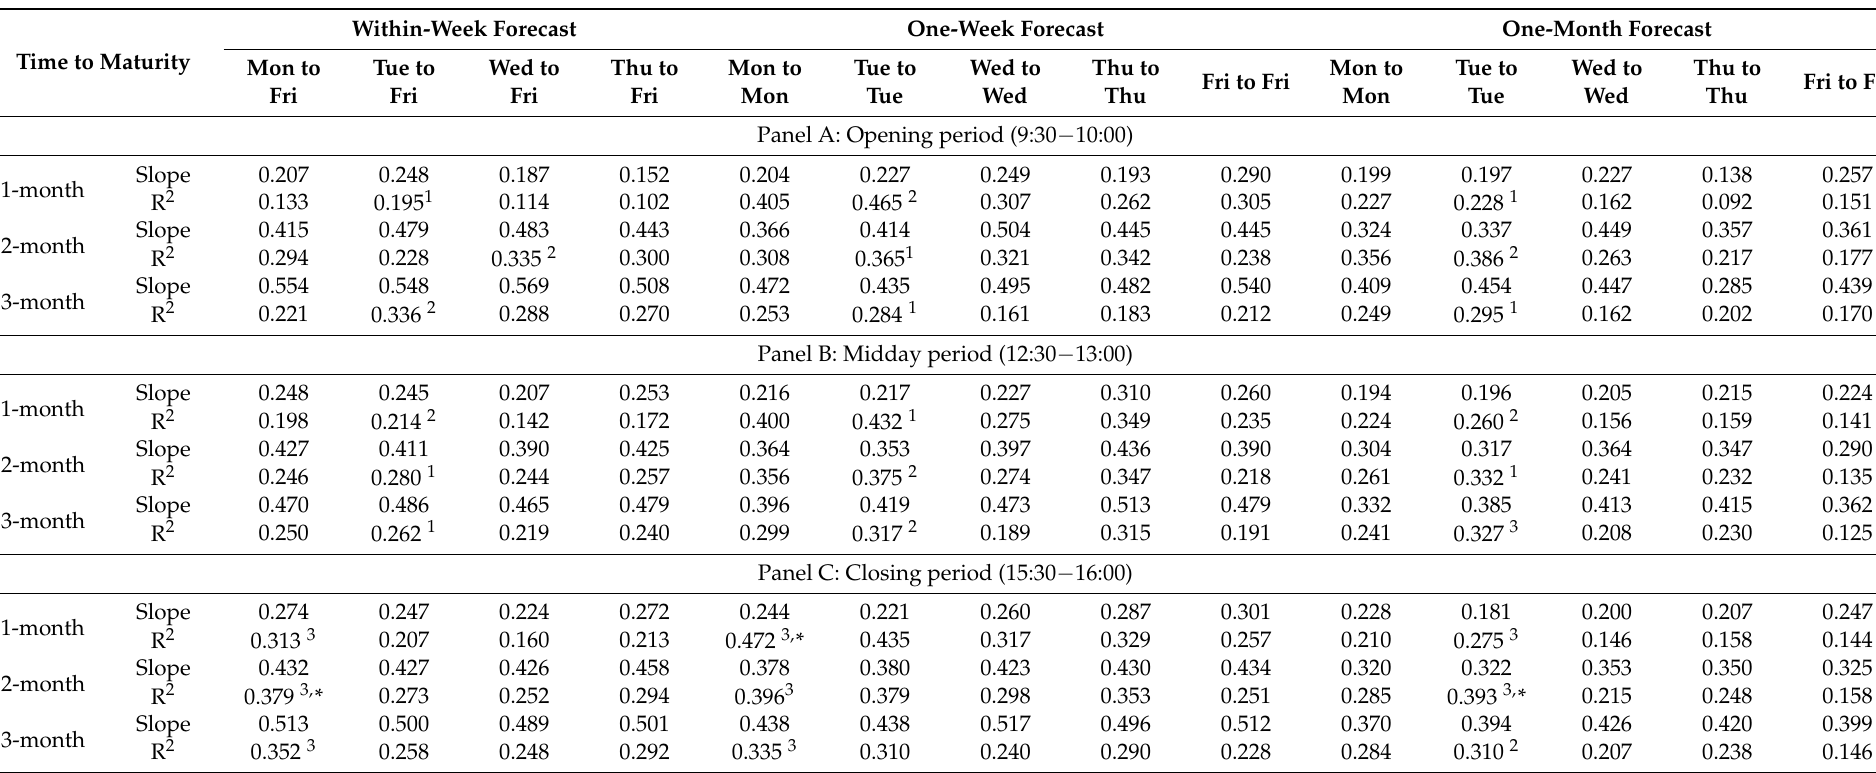
Table 1. Implied volatility (IV) forecast realised volatility ( RV ) for Australian dollar (AUD) options for within-week, one-week, and one-month forecast horizon. Within-Week Forecast One-Week Forecast One-Month Time to Maturity